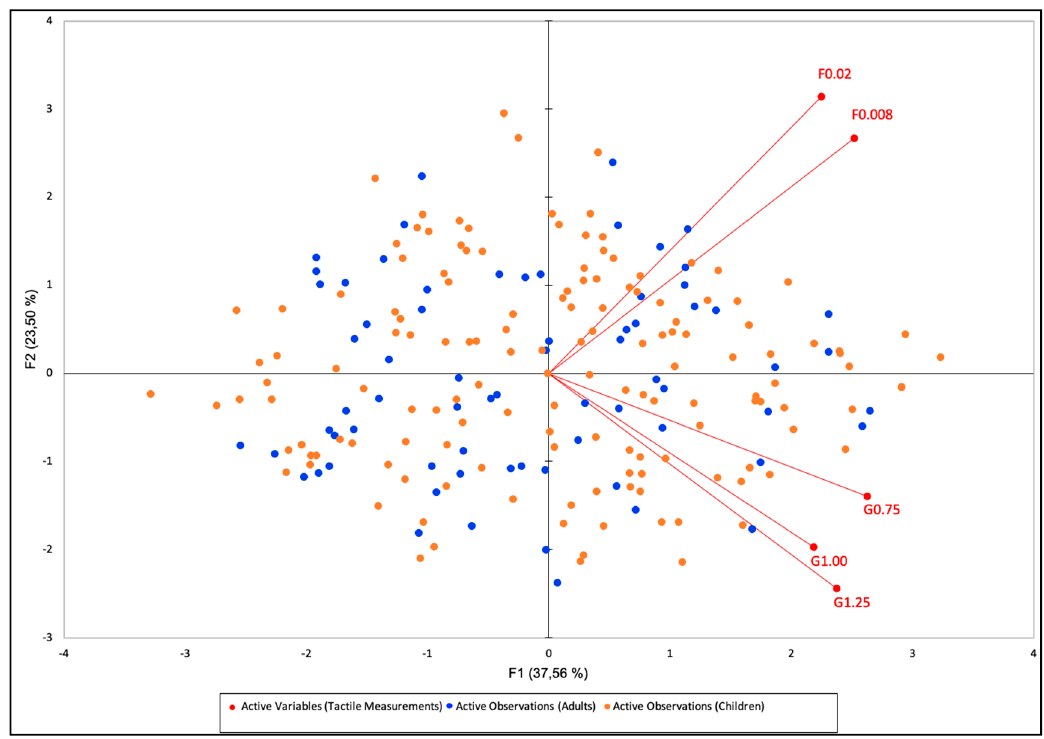
Figure 7. Biplot from the principle component analysis (PCA) performed on individual R-index values over all subjects ( n = 217).